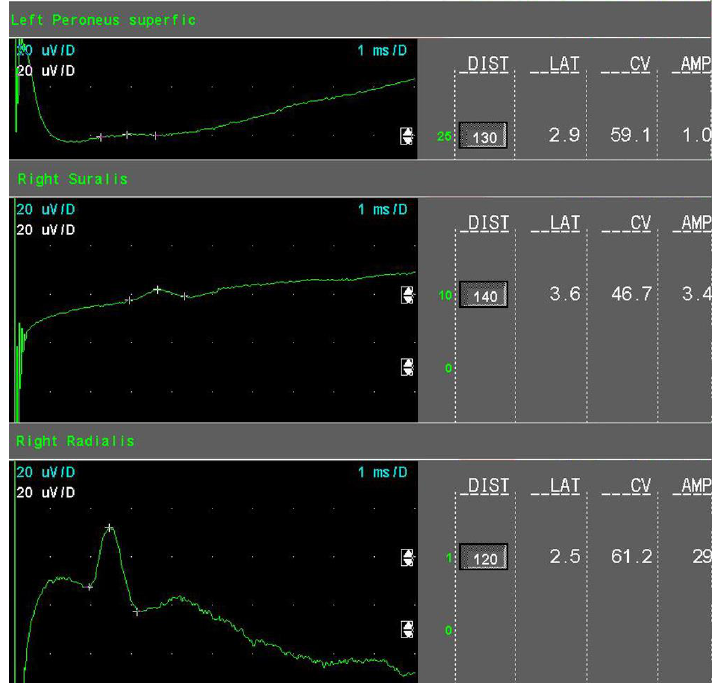
Figure 1. Sensory nerves conduction studies in mild sensory axonal loss (example).